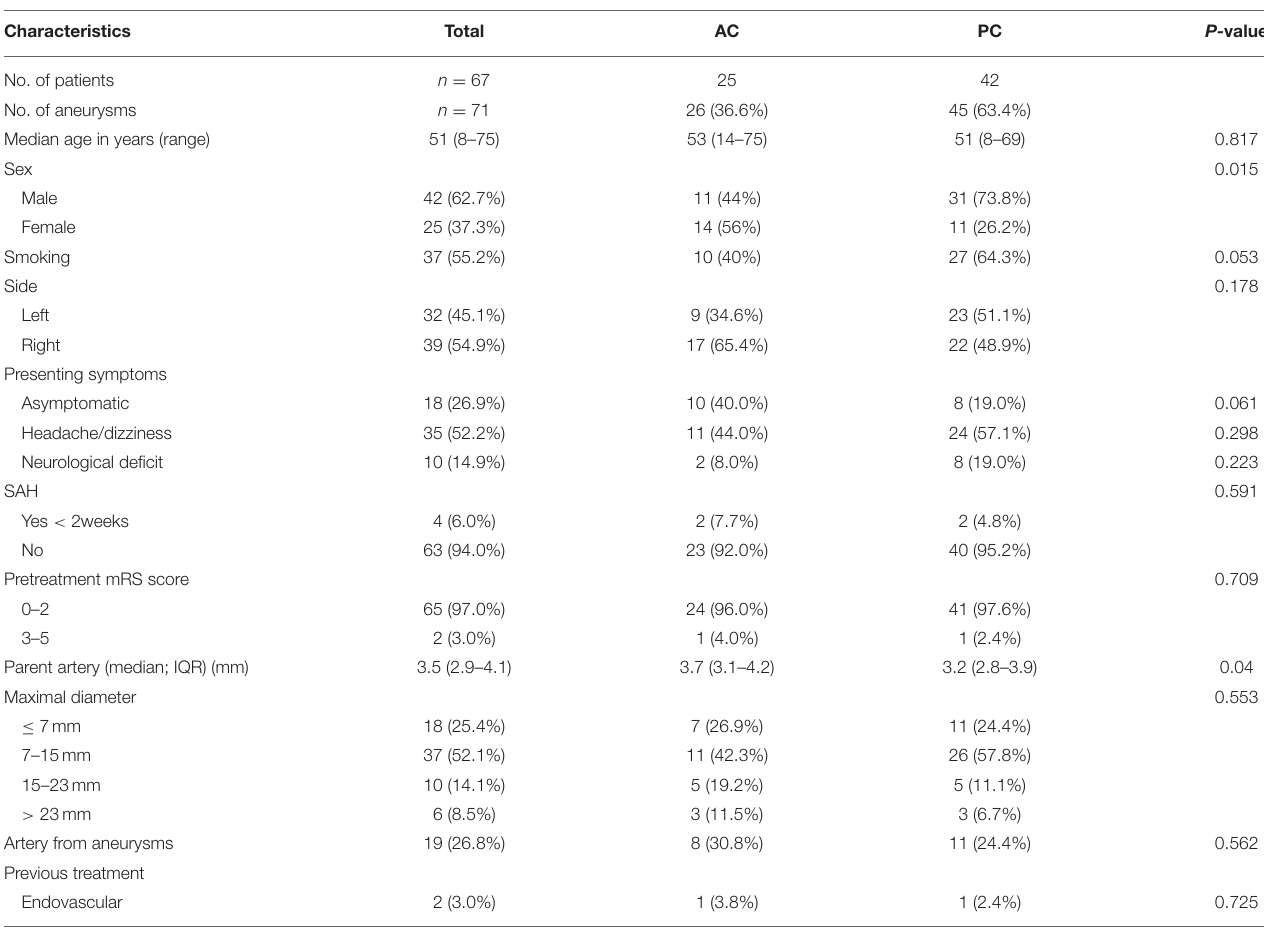
TABLE 2 | Baseline characteristics of 67 patients with 71 fusiform